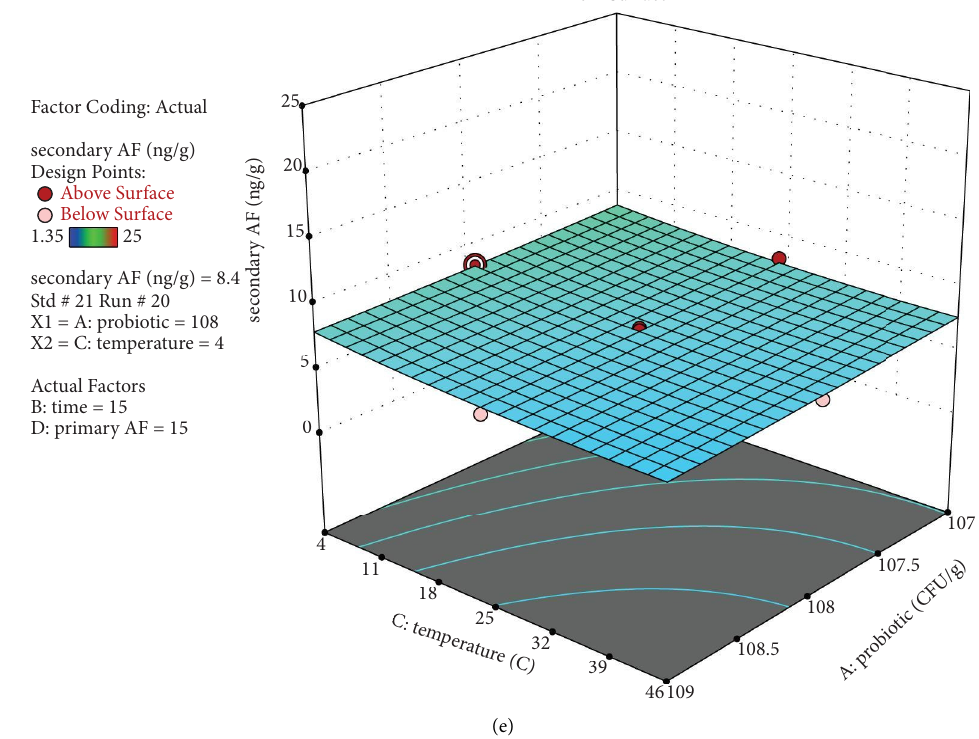
Figure 2: Interaction of time (15 days) and the inoculated afatoxin level (15 ng/g) on the afatoxin residue in pistachio